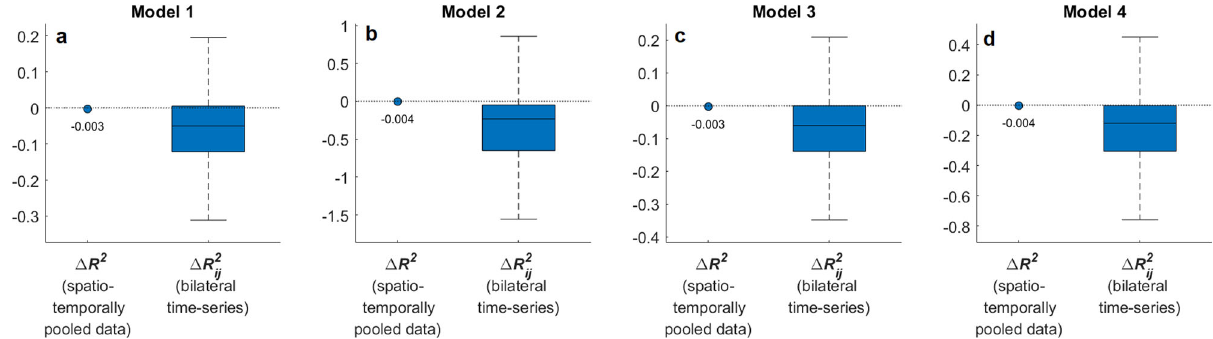
Fig. 4 Modelled and observed temporal changes in migration fl ows at the bilateral level. In panels a – d , the Δ R 2 values represented by markers correspond to the comparisons shown in Fig. 2a – d, respectively. Boxplots (not showing outliers, which are as small as − 11, − 3.0 × 10 8 , − 12, and − 3.1 × 10 8 for Models 1 – 4, respectively) represent the set of R 2 values obtained from the comparison of modelled and observed annual data over time for each speci fi c combination of origin and destination countries (Eq.